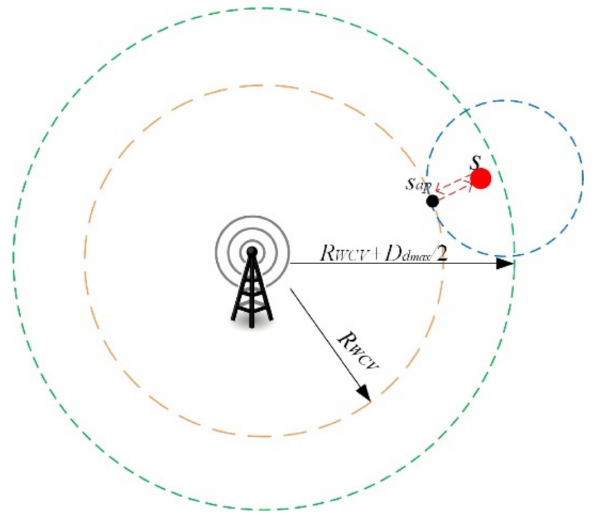
Figure A1. There exists a direct flight path from a releasing stop in the WCV region to the target node (Case